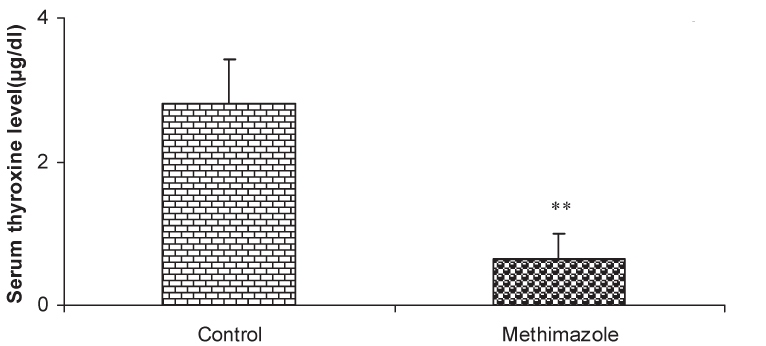
Figure 1 - Serum thyroxine concentrations ( m g/dl) in offspring of methimazole and control groups. The animals in the control group received regular drinking water, whereas the methimazole group received the water supplemented with 0.03% methimazole. Data are shown as mean ¡ SEM (n=7 in each group). ** P , 0.01 compared to controls.